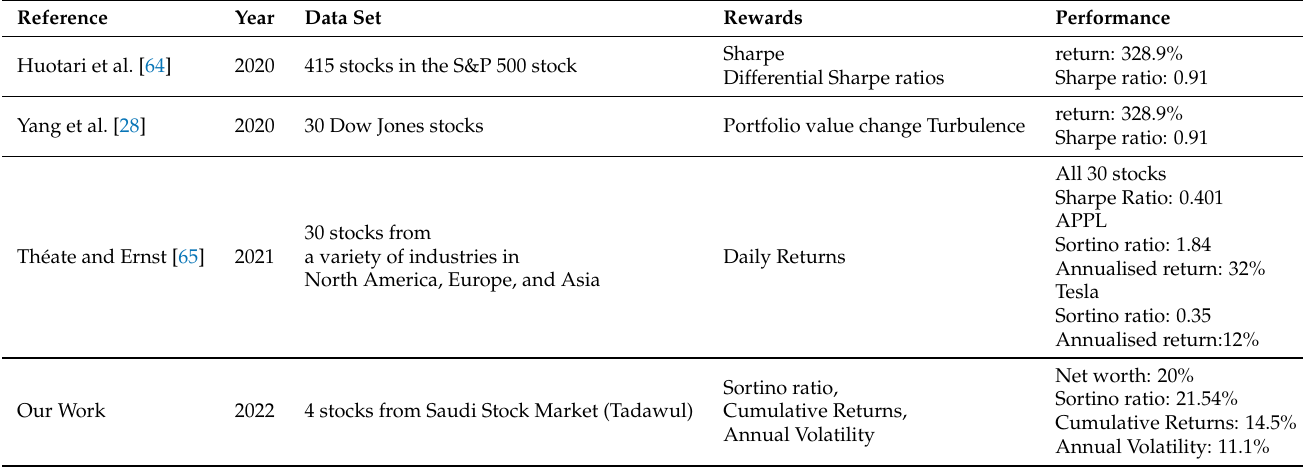
Table 5. Comparative Performance Analysis of Our Model with Other